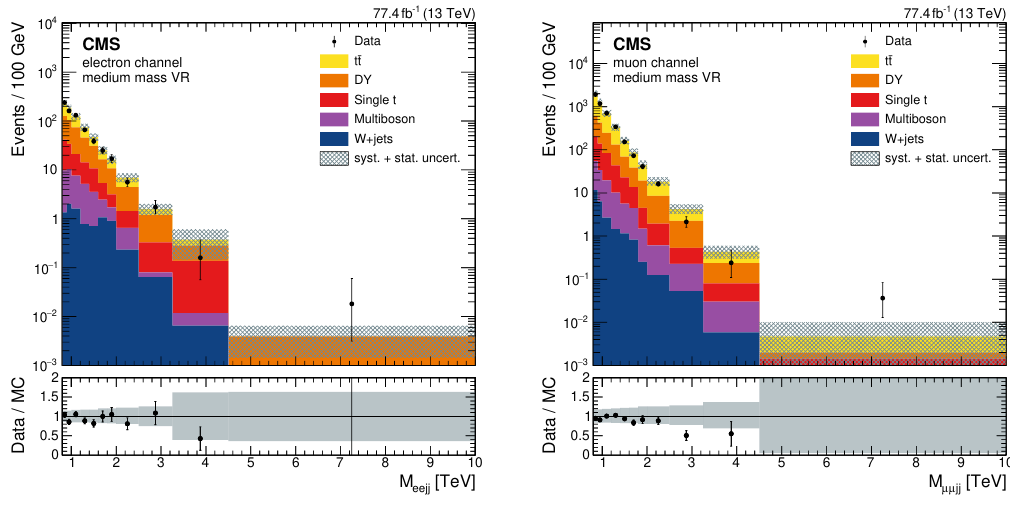
Figure 5 . Event distribution as a function of the four-body invariant mass M (left) and muon (right) channels, for the medium-mass validation region de(cid:12)ned by 200 < M 500 GeV. The lower panel shows the ratio of data to the simulated SM background, with the shaded band representing the uncertainty.